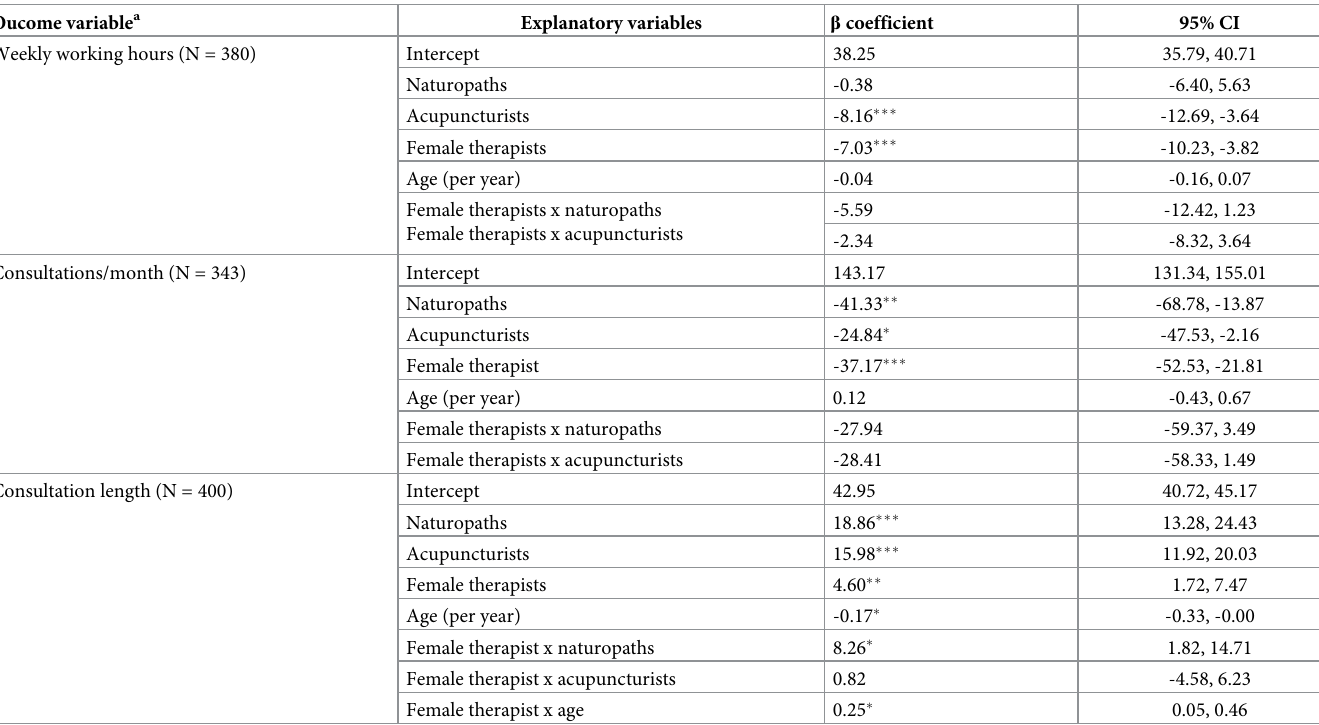
Table 6. Determinants of workload: Multivariate analysis (linear